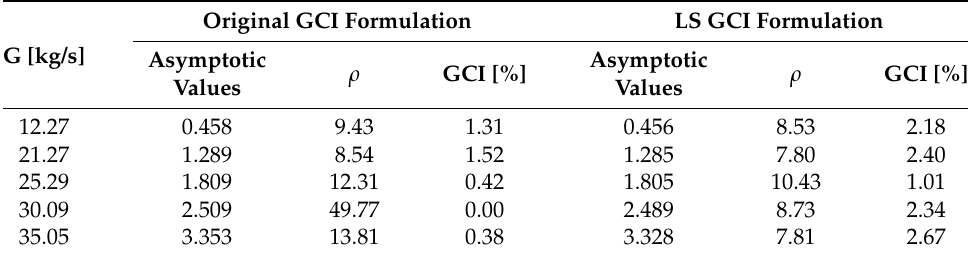
Figure 11. Relative error with respect to the LS asymptotic values. Table 7. Overview of the grid independence studies.